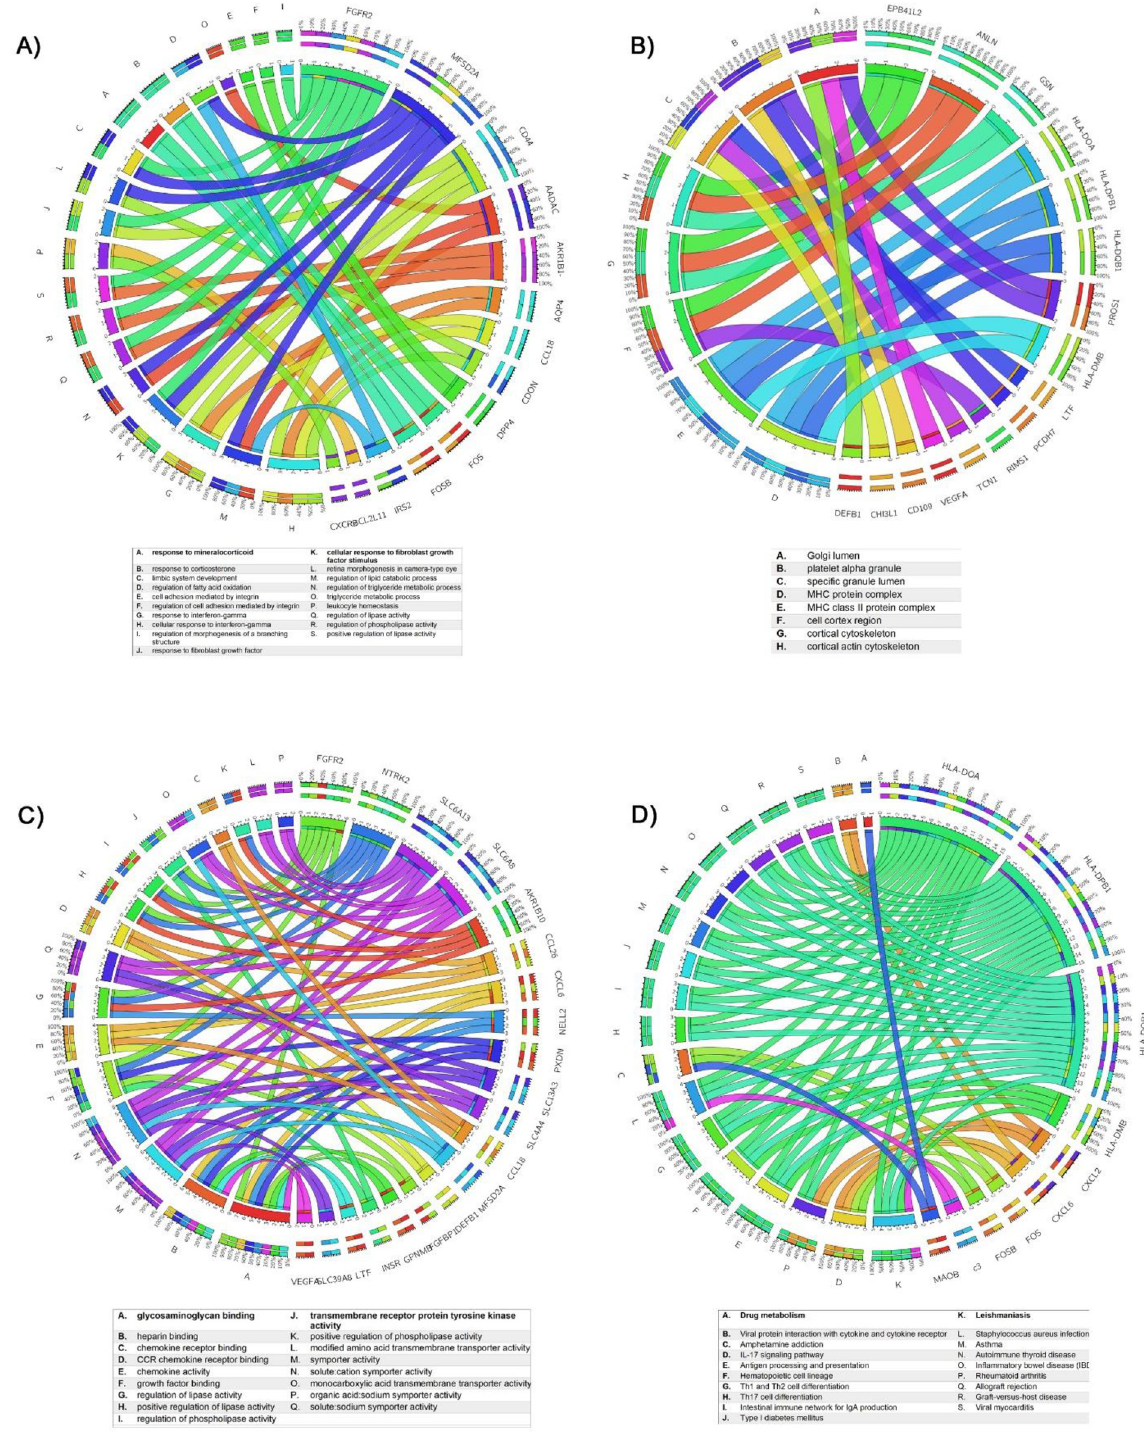
Fig 2. The Circos plot representation of GO-Annotation terms of differentially expressed genes. a) biological process b) cellular components c) molecular function d) KEGG pathways (Cricos plot generated from http://mkweb.bcgsc.ca/tableviewer/).